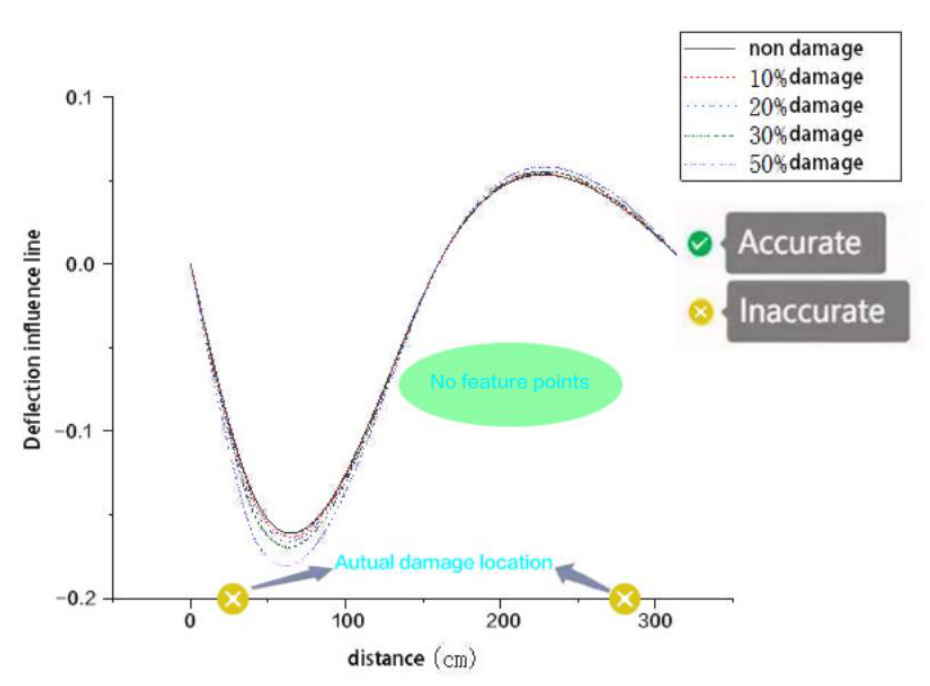
Figure 9. Deflection influence of 1/4 determining point of the 1st span following work condition 1